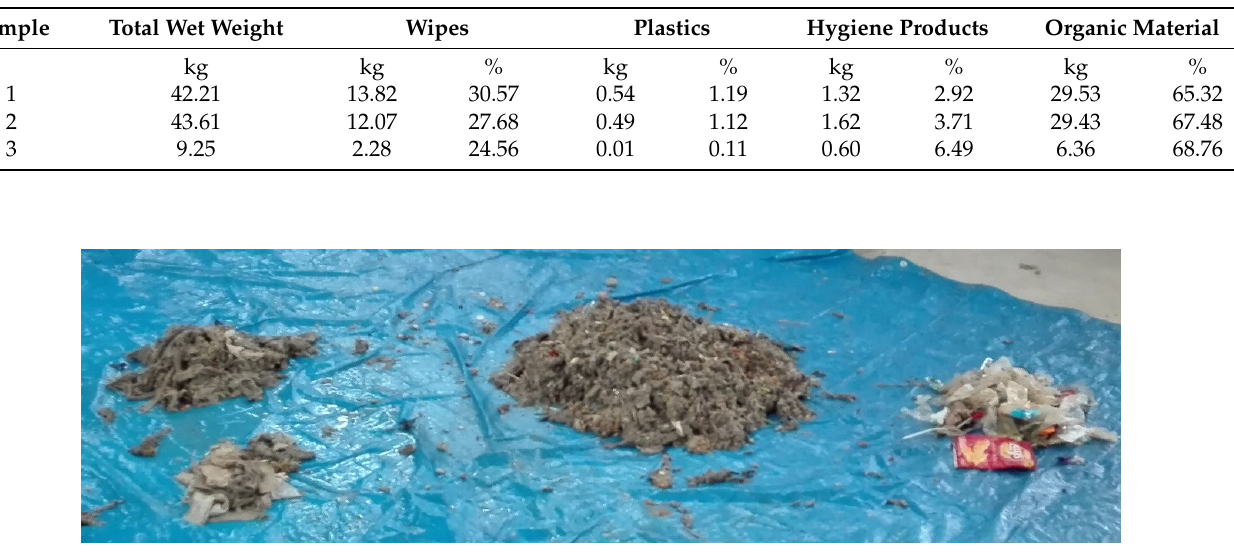
Table 1. Design parameters of the Villapérez wastewater treatment plant (Asturias, Spain). Parameter